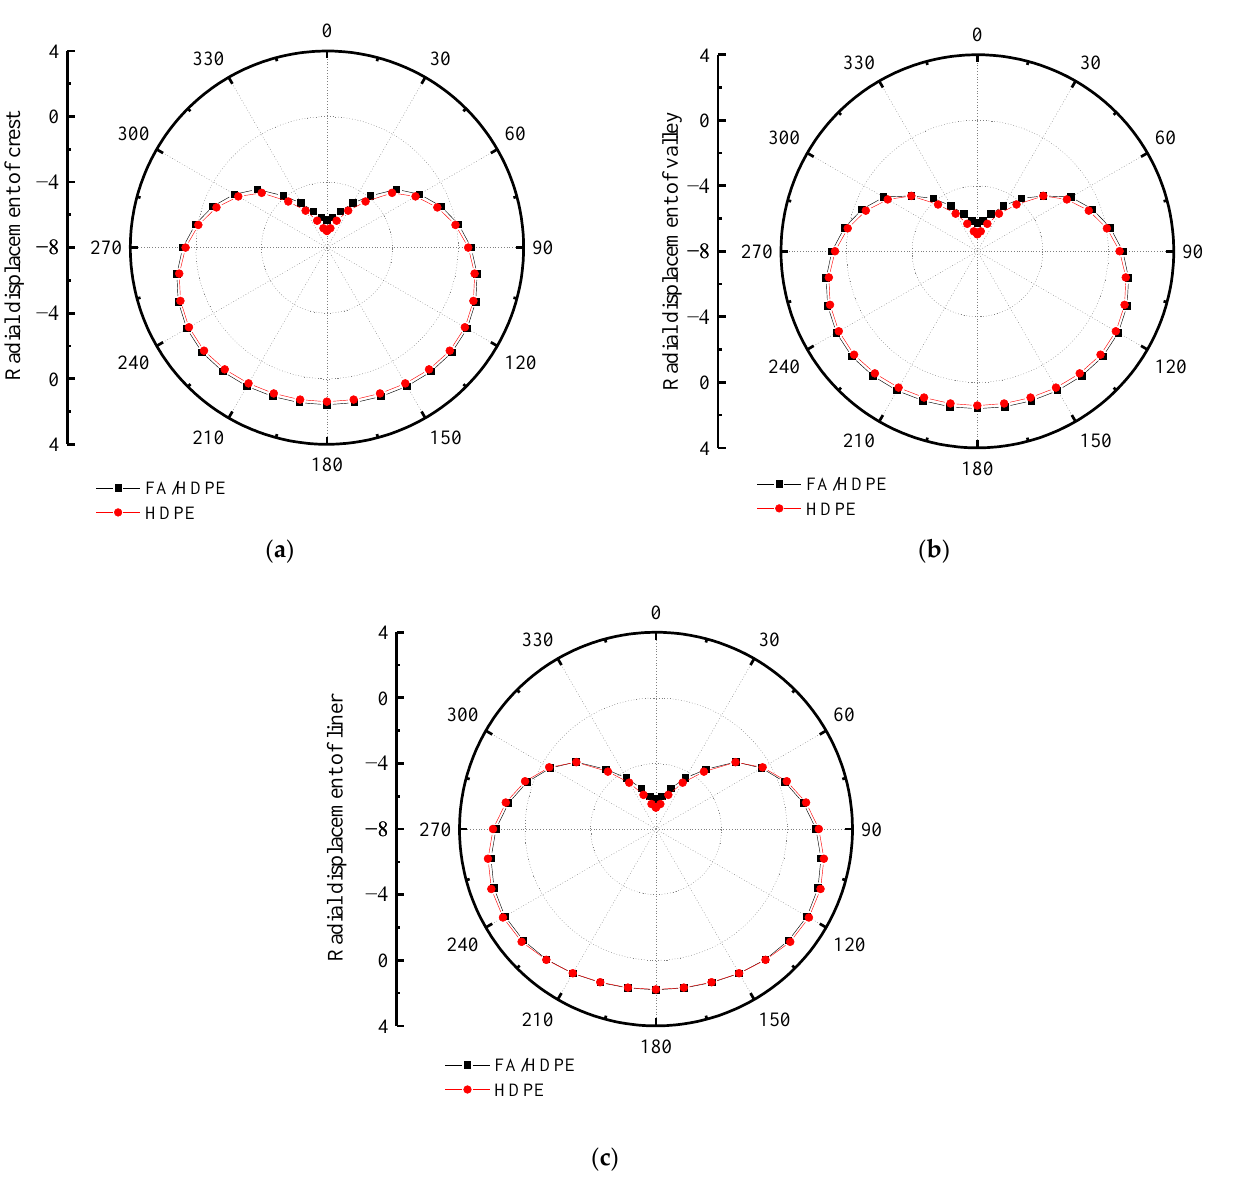
Figure 13. Comparison of radial displacement between HDPE and FA/HDPE of double-wall corru- gated pipes. ( a ) Crest; ( b ) Valley; ( c ) Liner.